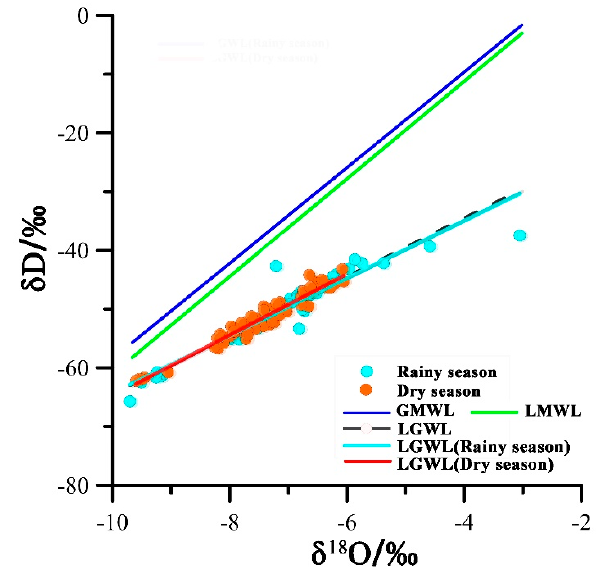
Figure 2. Local groundwater line (LGWL) for the study area across season, based on the data of individual sampling from May 2015 to April 2016.